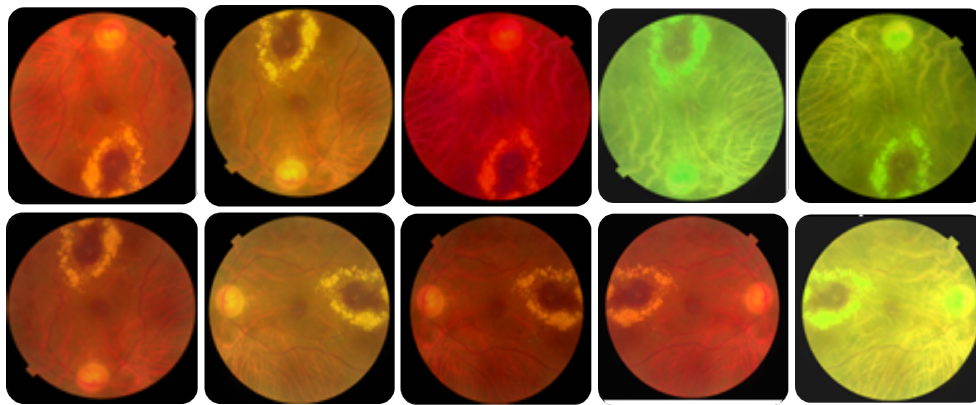
Figure 3. An example of the augmented images. Table 3. Data augmentation